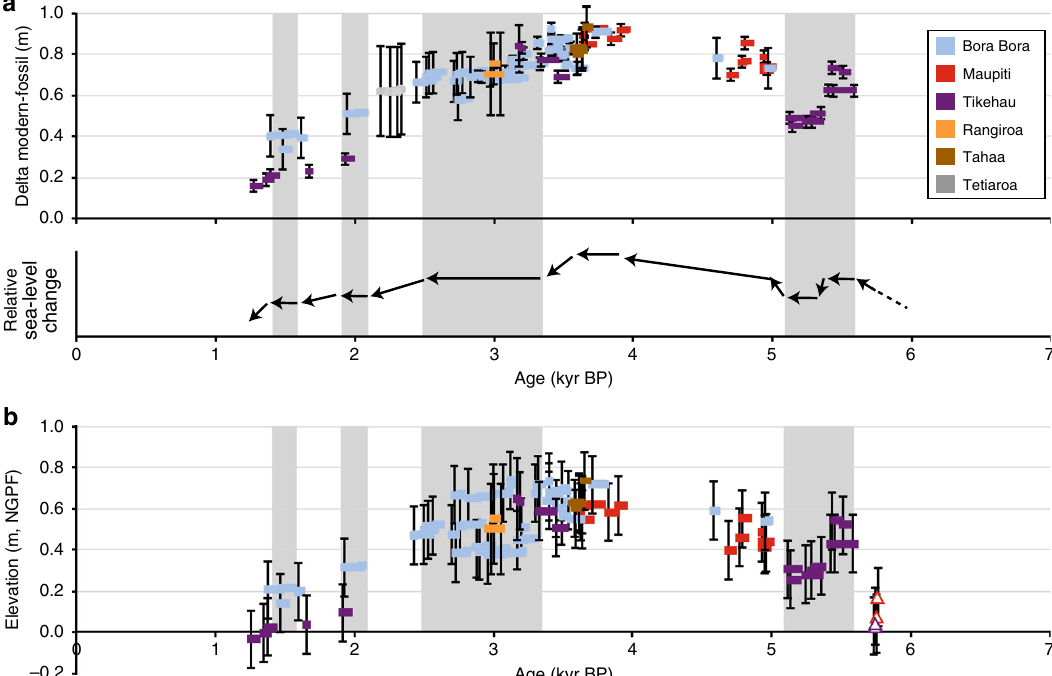
Fig. 5 Mid- to late-Holocene sea-level curve for French Polynesia. Age vs. elevation plot of dated microatolls (solid symbols) and reef fl at facies (open symbols); GIA corrections were not applied to the data. Calculated elevations are based on a the height difference between living microatolls and their fossil counterparts ( ‘ Delta modern-fossil ’ ) and b NGPF measurements (geodetic datum in French Polynesia, see 'Methods' section). Error values for ages and elevations are 2-sigma (see 'Methods' section and Supplementary Table 1). Relative sea-level changes are indicated by the direction of the arrows. Horizontal bars illustrate large microatolls, which developed during periods of relative sea-level stillstands. The grey shaded areas indicate speci fi c time windows characterised by these century-scale stillstands. Data concerning Tetiaroa were obtained during a parallel study (A.E.,